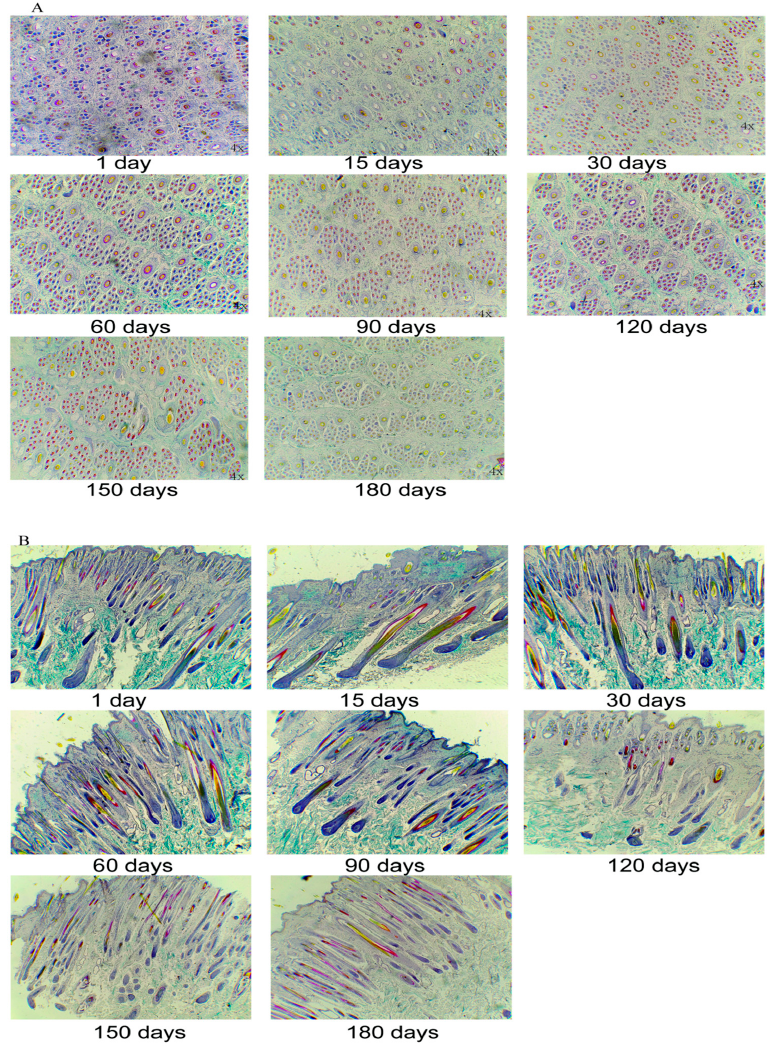
Figure 1. Morphological changes of hair follicles at different time points, ( A ) cross section, 40 × ( B ) longitudinal section, 40 ×